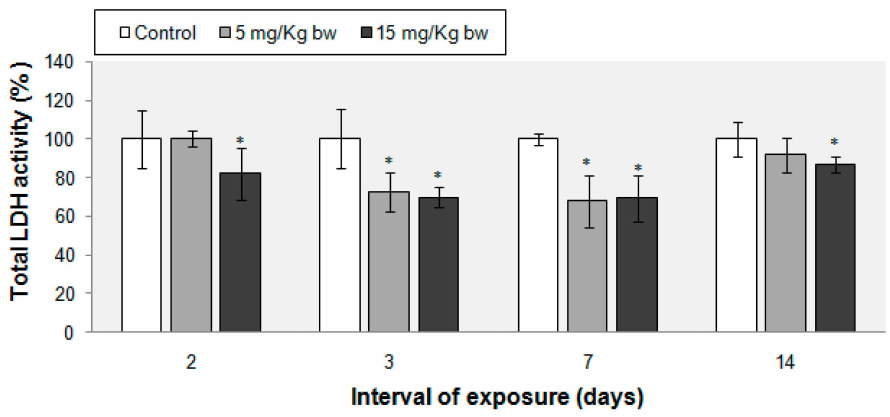
Figure 3. Changes of total LDH activity in mouse lung tissue exposed to IONPs-PM. Activity was calculated as means ˘ standard deviation ( n = 7) and expressed as % from controls. * Means significantly different from controls ( p < 0.05, α (significance level) =